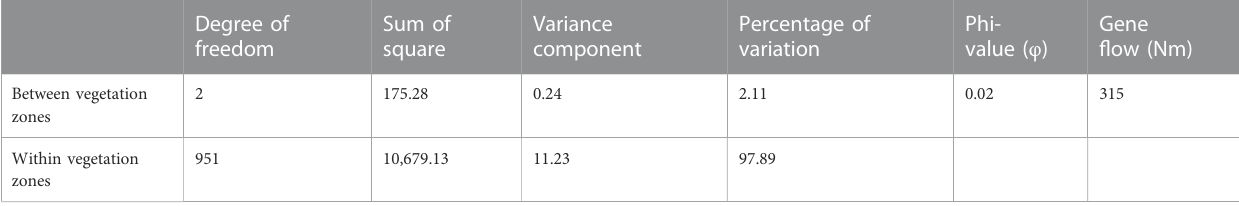
TABLE 2 Analysis of molecular variance (AMOVA) of the 954 goats within and among the three vegetation zones of Benin. Degree of freedom Between vegetation zones